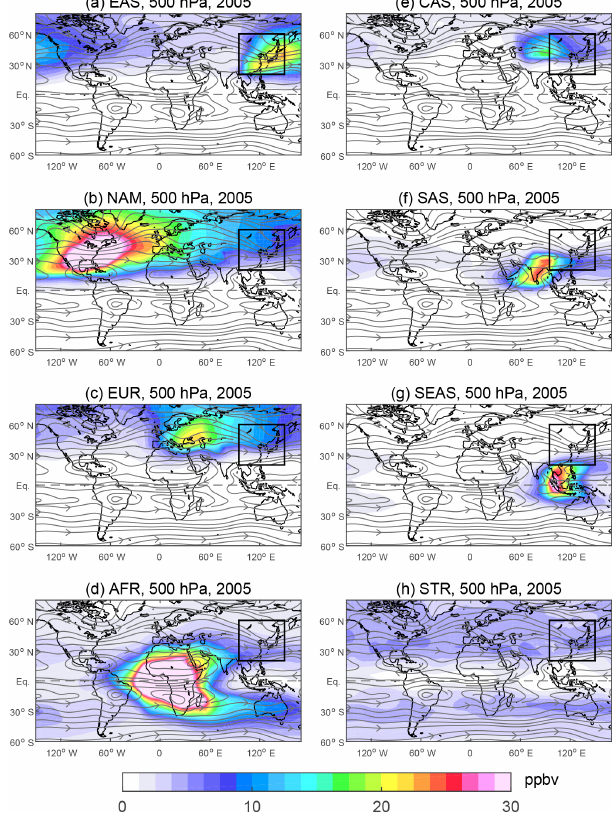
Figure 8. Horizontal distributions of ozone produced in differ- ent regions in the middle troposphere (500hPa) averaged in 2005. The boxed area indicates East Asia. The abbreviations are for (a) East Asia (EAS), (b) North America (NAM), (c) Europe (EUR), (d) Africa (AFR), (e) central Asia (CAS), (f) South Asia (SAS), (g) South-east Asia (SEAS), and (h) the stratosphere